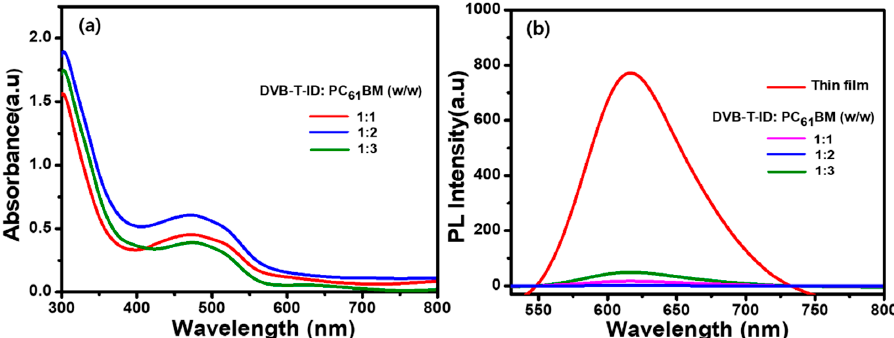
Figure 3. ( a ) UV-Vis absorption and ( b ) PL spectra of DVB-T-ID:PC 61 BM) thin films of di ff erent blend ratios (1:1, 1:2, and 1:3 ( w / w